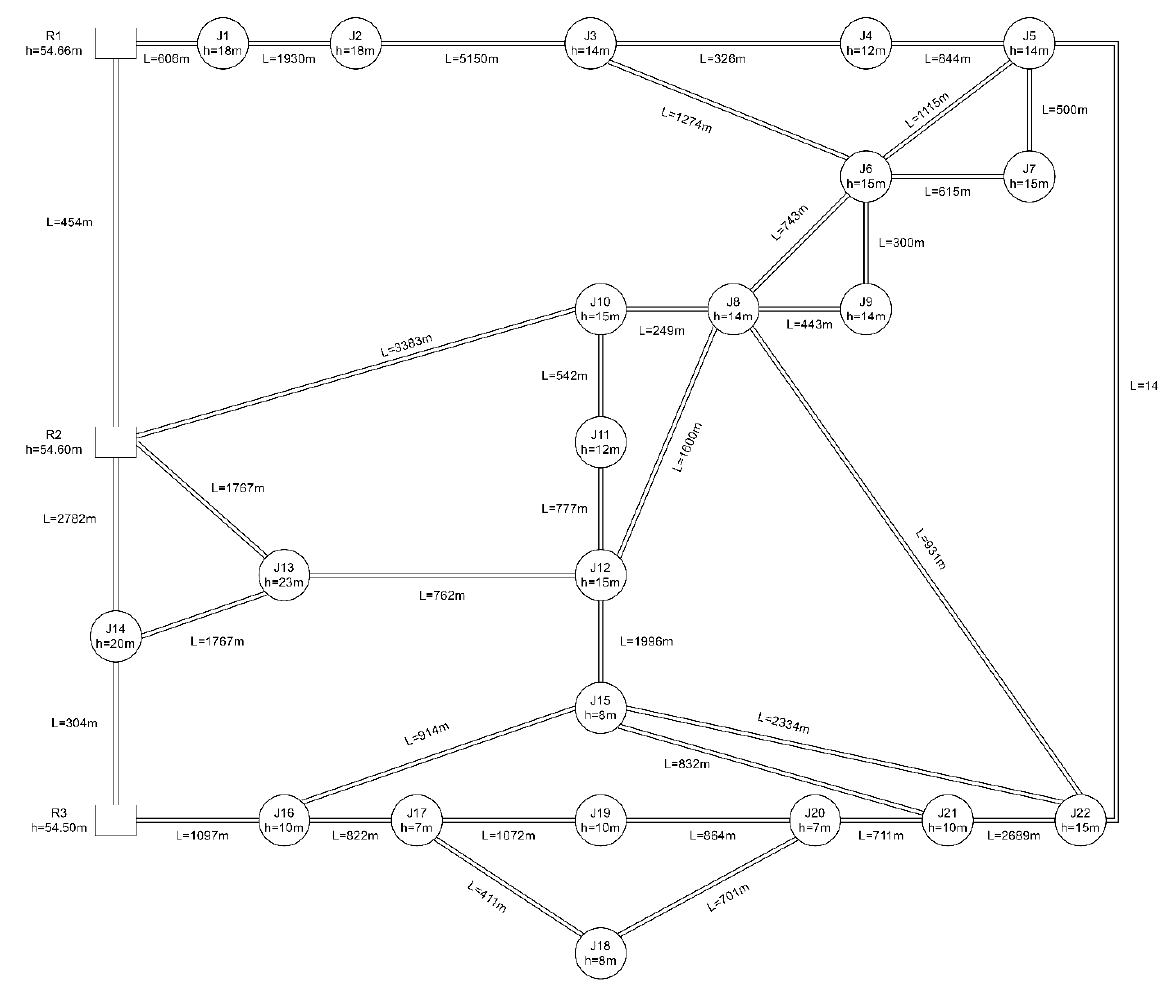
Figure 2. Sketch diagram of Jowitt and Xu Water Distribution System. Table 2. Link IDs, Diameters, and Lengths of the WDN under